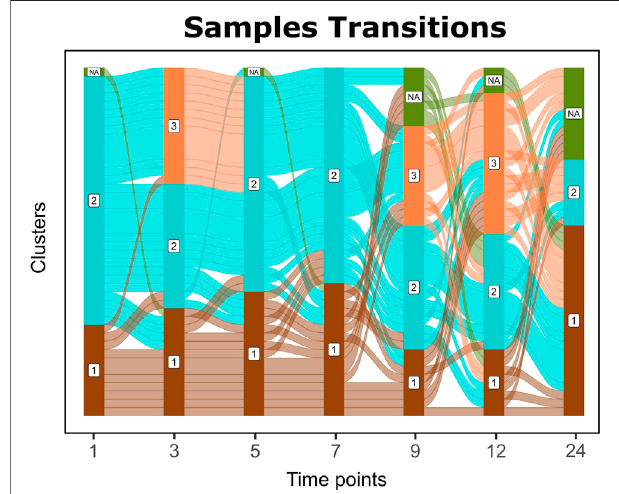
FIGURE 4 | Alluvial graph of sample transitions between clusters over time. NAs represent nonavailable data for the corresponding time point, whereas 1, 2, and 3 represent the cluster on the corresponding time point.